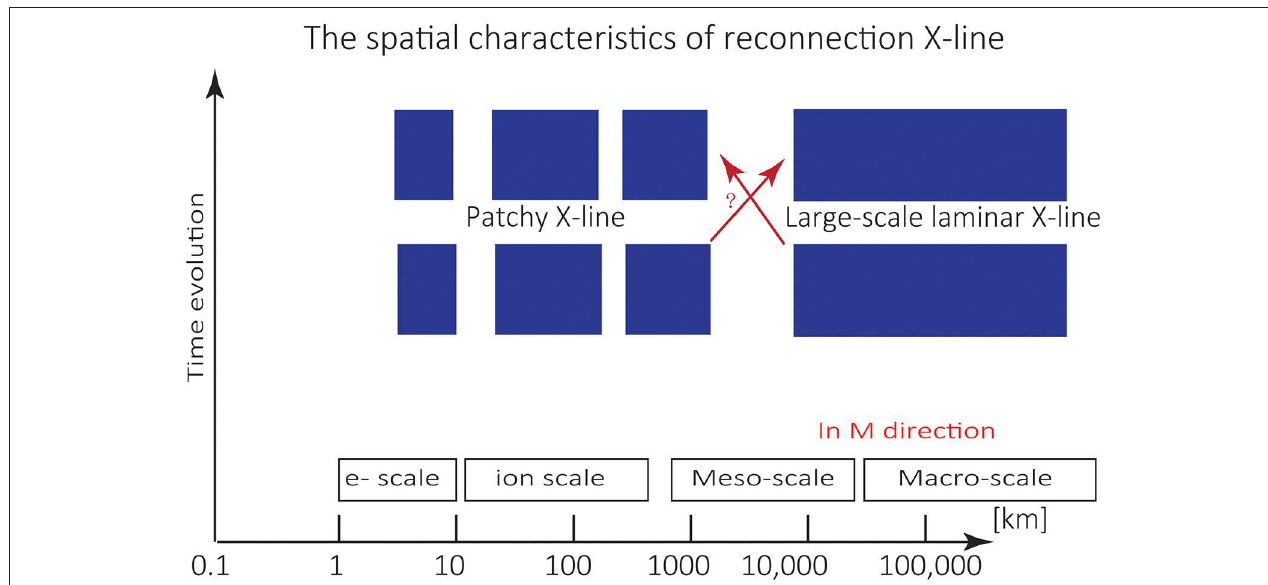
FIGURE 4 | Science questions of AME mission. Spatial scales of magnetic reconnection X-line.